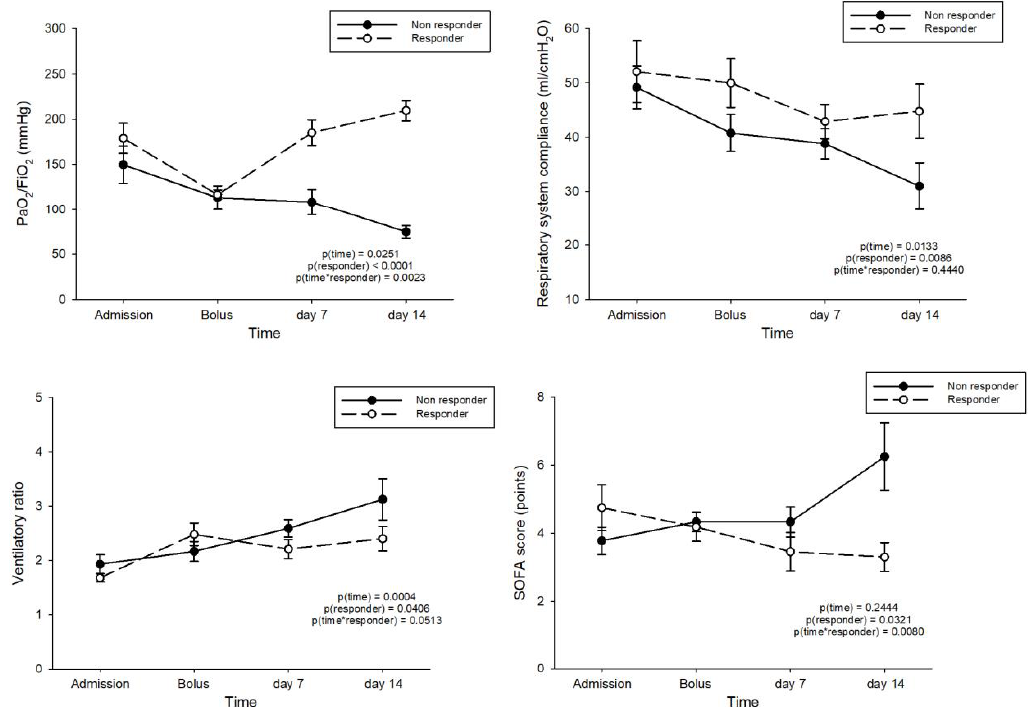
Figure 1. Time course of PaO 2 /FiO 2 ratio, respiratory system compliance, ventilatory ratio, and the SOFA score at ICU admission, at the time of the bolus, and after 7 and 14 days in patients classified as responders (black dots) vs. non-responders (white dots) to the high-dose bolus of corticosteroids. The comparison between responders and non-responders was performed by analysis of variance for repeated measurements, with time as a within-subject factor and the response to the bolus as a fixed, between-subject factor. The model included the interaction effect of time on the response to the bolus (time*responder). The statistical significance of the within-subject factors was corrected with the Greenhouse – Geisser method. Table 3. Comparison of baseline characteristics and worst clinical data over the first 10 days of stay in patients who did vs. those who did not receive a short, rescue course of high-dose boluses of steroids.